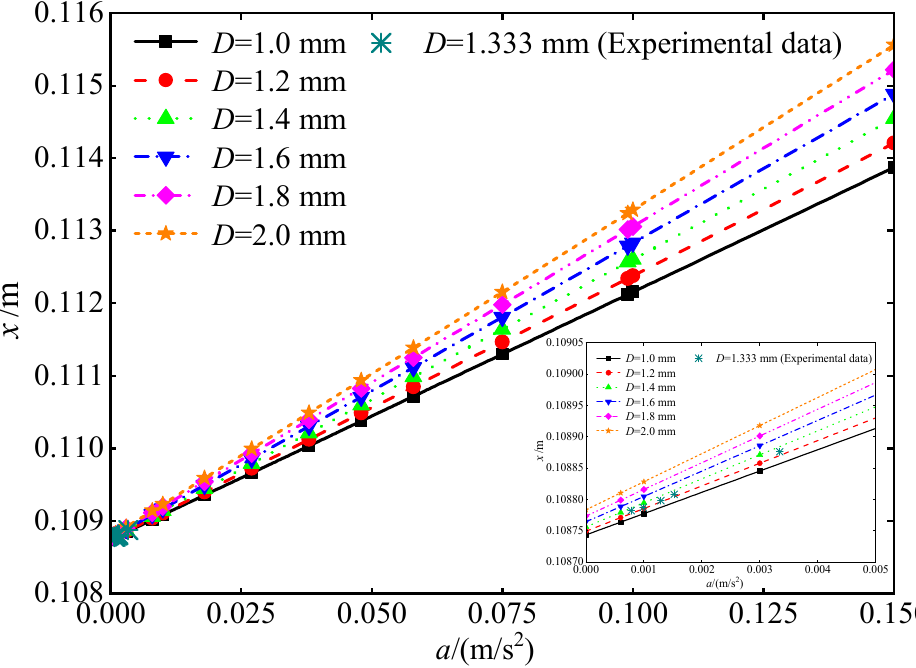
Figure 14. Relationship between the travel distance and velocity skewness of sediment